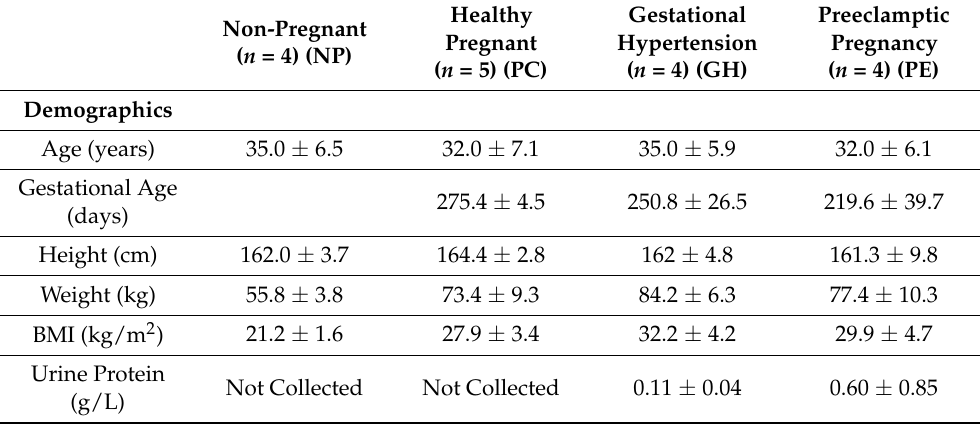
Table 1. Demographics, Anthropometrics and Platelet Indices in Study